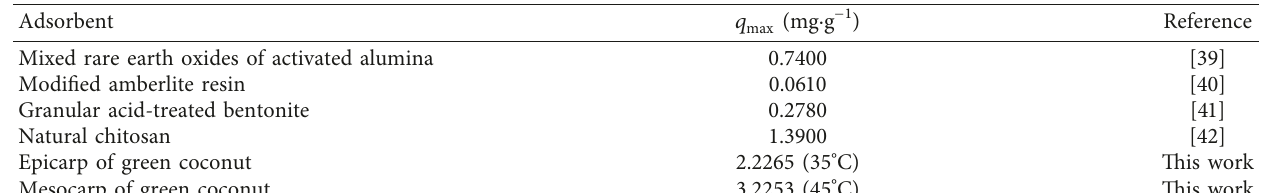
Table 4: Maximum adsorption capacity of some adsorbents for fluoride ions removal.